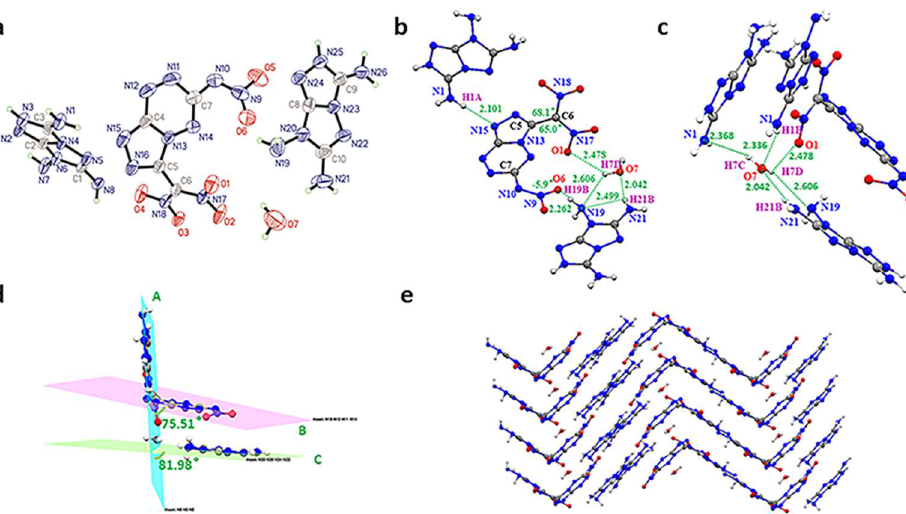
Figure 3. ( a ) Molecular structure of 4 (). ( b ) Hydrogen bonds of 4 (green dash line). ( c ) Hydrogen bonds (green dash line). resulting with H 2 O to connect molecules to form layers. ( d ) Planarity of 4 (bright blue for plane A, purple for plane B, green for plane C). ( e ) Crystal packing diagram of 4 (blue for nitrogen atoms, red for oxygen atoms)